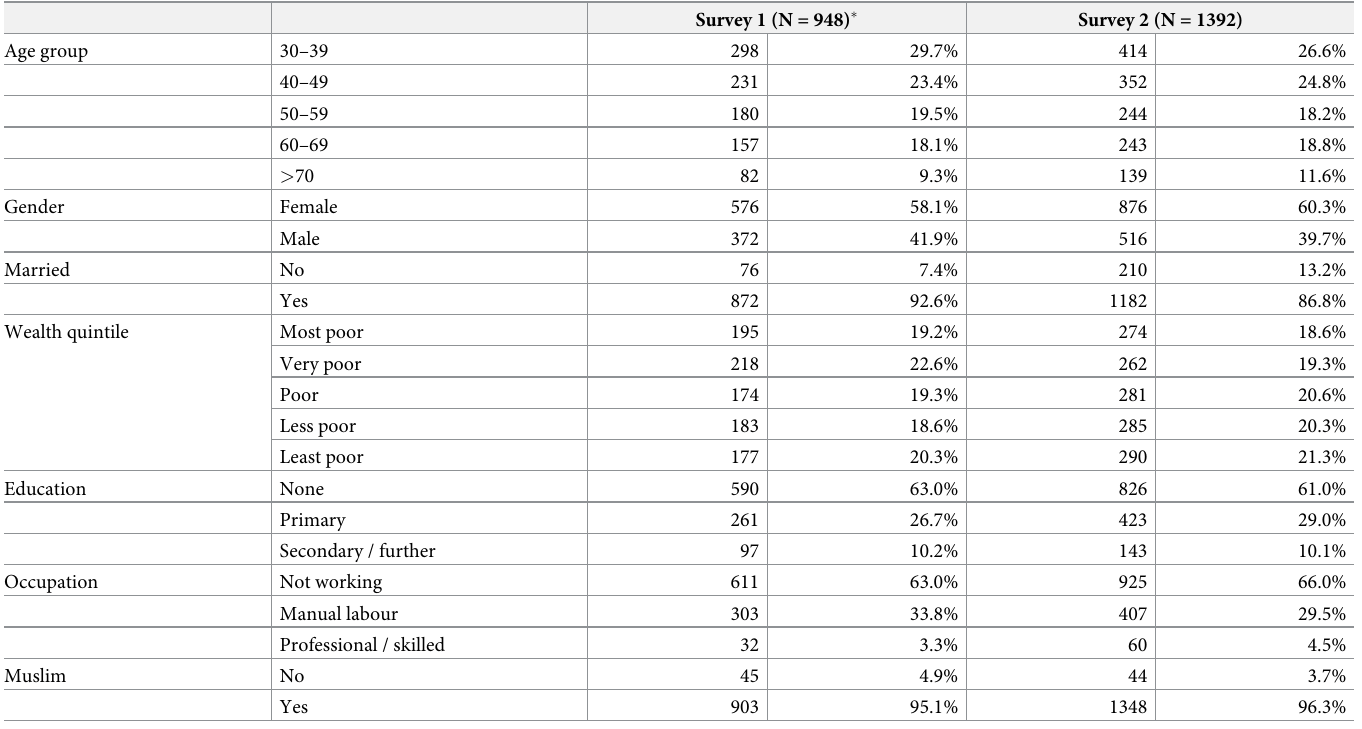
Table 2. Demographic characteristics of participants in both